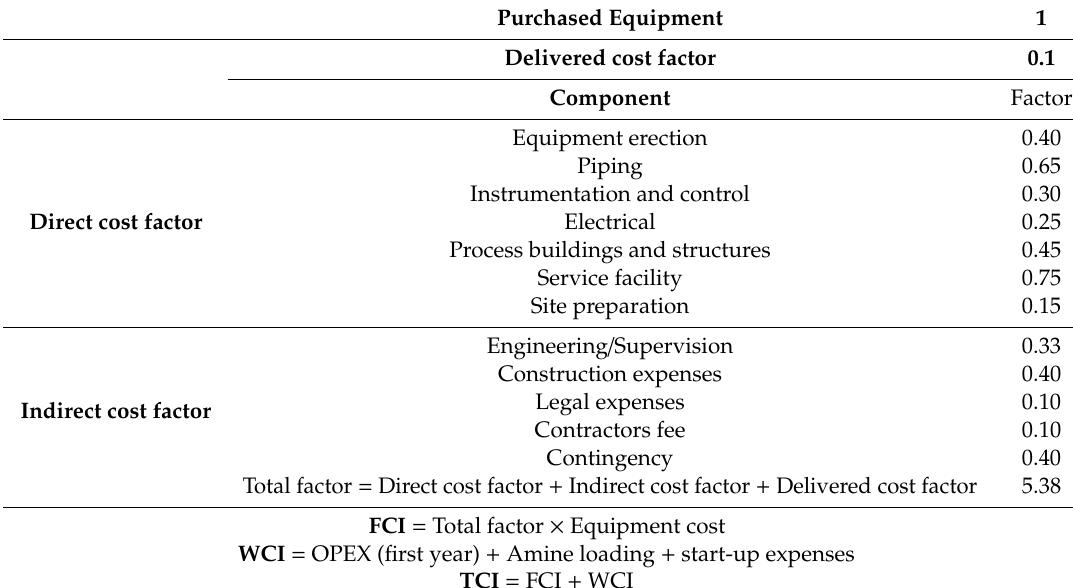
Table 4. Direct and indirect cost factors and its percentage to purchased